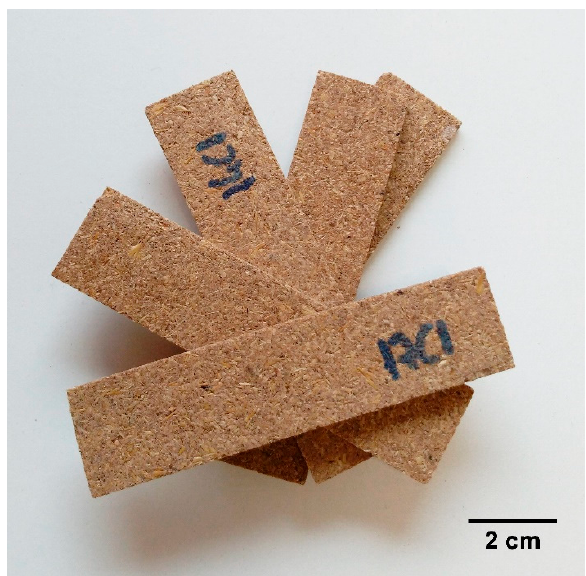
Figure 3. Samples (10 cm × 2.5 cm × 0.43 cm) cut from trays produced with 60%